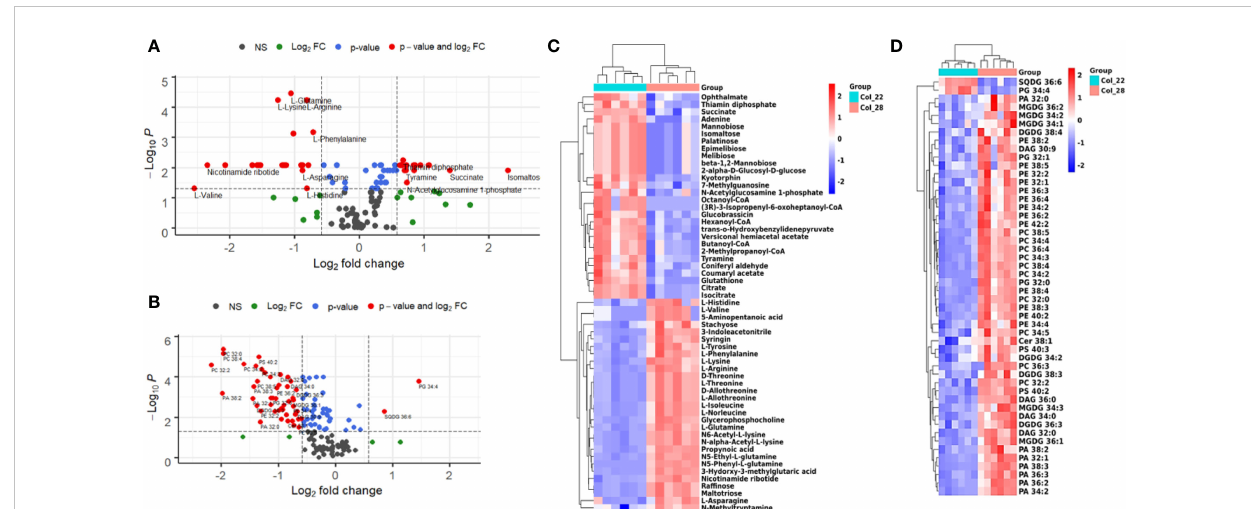
FIGURE 6 Distinguished analysis of metabolites and lipids for Arabidopsis seedling growth between 22°C and 28°C. (A) Distinct metabolites between 22°C and 28°C were analyzed by volcano plot. X-axis was Log 2 fold change and the y-axis was – Log 10 P value. The red dots on the left indicated that metabolites level of seeds germination at 22°C signi fi cantly reduced, compared with 28°C. The red dots on the right indicated metabolites level signi fi cantly increased. Blue dots represented metabolites with only P <0.05 and green dots represent metabolites with only FC>1.5. Gray dots referred to all other identi fi ed metabolites with no signi fi cant changes between 22°C and 28°C. (B) Distinct lipids between 22°C and 28°C were analyzed by volcano plot. X-axis was Log 2 fold change and the y-axis was – Log 10 P value. The red dots on the left indicated that lipids of seeds germination at 22°C signi fi cantly reduced level, compared with 28°C. The red dots on the right indicated lipids level signi fi cantly increased. Blue dots represented metabolites with only P <0.05 and green dots represent metabolites with only FC>1.5. Gray dots referred to all other identi fi ed metabolites with no signi fi cant changes between 22°C and 28°C. (C) Heatmap showing Z score scaled the alteration of metabolites between 22°C and 28°C. The relative enrichment of each metabolite in different samples were arranged in rows, and the relative levels of all metabolites in each sample were distributed in columns. The grids in heatmap represented metabolites, and shades of color represented relative level of metabolites. Red and blue colors indicate an increase and a decrease of metabolite level, respectively, and white color means no change. Col_22 means seeds germinated at 22 °C, Col_28 means seeds germinated at 28°C. (D) Heatmap showing Z score scaled the alteration of lipids between 22°C and 28°C. The relative enrichment of each lipid in different samples were arranged in rows, and the relative levels of all lipids in each sample were distributed in columns. The grids in heatmap represented lipids, and shades of color represented relative level of lipids. Red and blue colors indicate an increase and a decrease of lipid level, respectively, and white color means no change. Col_22 means seeds germinated at 22 °C, Col_28 means seeds germinated at